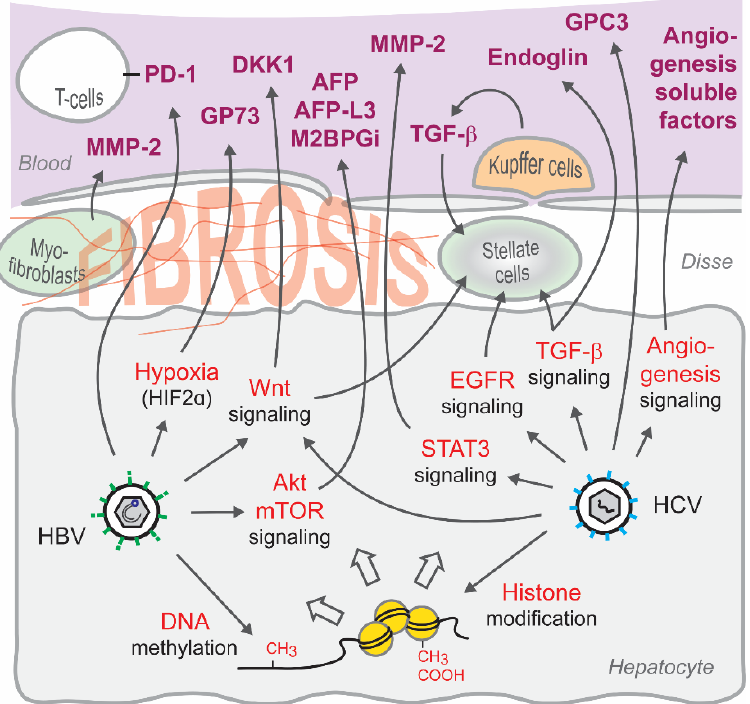
Figure 1. Dysregulation of signaling pathways by chronic viral hepatitis and epigenetic imprinting impact the secretion of circulating candidate biomarkers to the blood. Abbreviations: AFP, alpha- fetoprotein; AFP-L3, Lectin-Binding AFP-3; Akt, AKT Serine/Threonine Kinase; DKK1, Dickkopf WNT Signaling Pathway Inhibitor 1; Disse, Space of Disse; EGFR, Epidermal Growth Factor Receptor; GPC3, Glypican 3; GP73, Golgi Membrane Protein 1; HIF2α, Hypoxia-Inducible Factor 2 Alpha; M2BPGi, mac-2-binding protein glycan isomer; MMP-2, Matrix Metallopeptidase 2; mTOR, Mechanistic Target Of Rapamycin Kinase; PD-1, Programmed Cell Death 1; STAT3, Signal Transducer and Activator of Transcription 3; TGF-β, Transforming Growth Factor Beta; Wnt, Wnt Family Member.